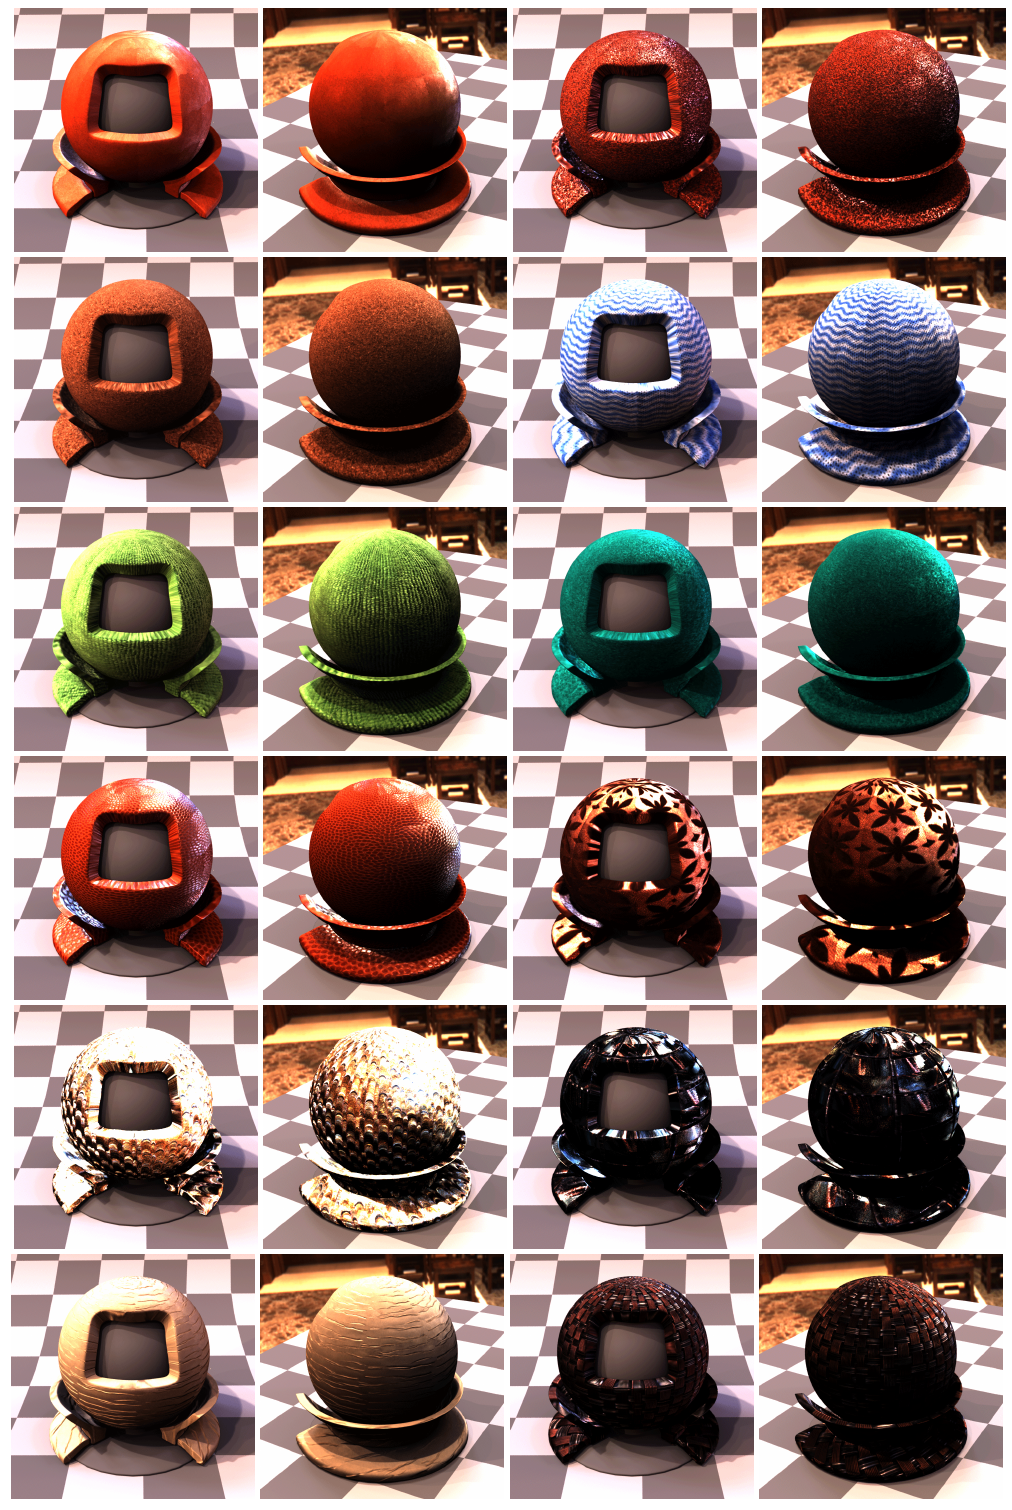
Figure 25. Twelve material samples from The MAM 2014 sample set, measured by lightdrum, put onto the 3D object and rendered by Mitsuba rendering software under two different views. Materials (top-left to bottom-right): 002-Sand-Fine, 003-Sand-Coarse, 005-Cork, 006-Towel, 007-GreenCloth, 008-GreenFelt, 009-Basketball, 010-FlockedPaper, 011-Silver-Gold, 014-Blue-Black-Gold, 015-Crinkle-Paper,